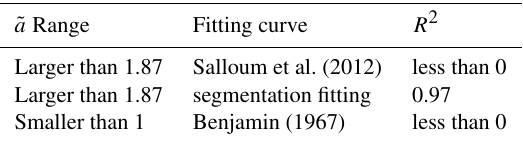
Figure 8. Relationship between the dimensionless wavelengths and the dimensionless amplitudes of the mode-2 ISWs observed in the study area. The black and red crosses denote the ISWs on the survey lines in the SW–NE and NE–SW directions, respectively. Table 4. Fitting effects of each curve in Fig. 8 on the observation points.